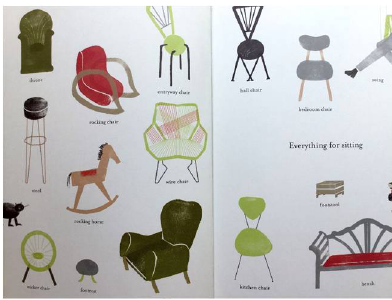
Figure 11. Stella G., Welcome to My House ; Chronicle Books, California 2017, [11].